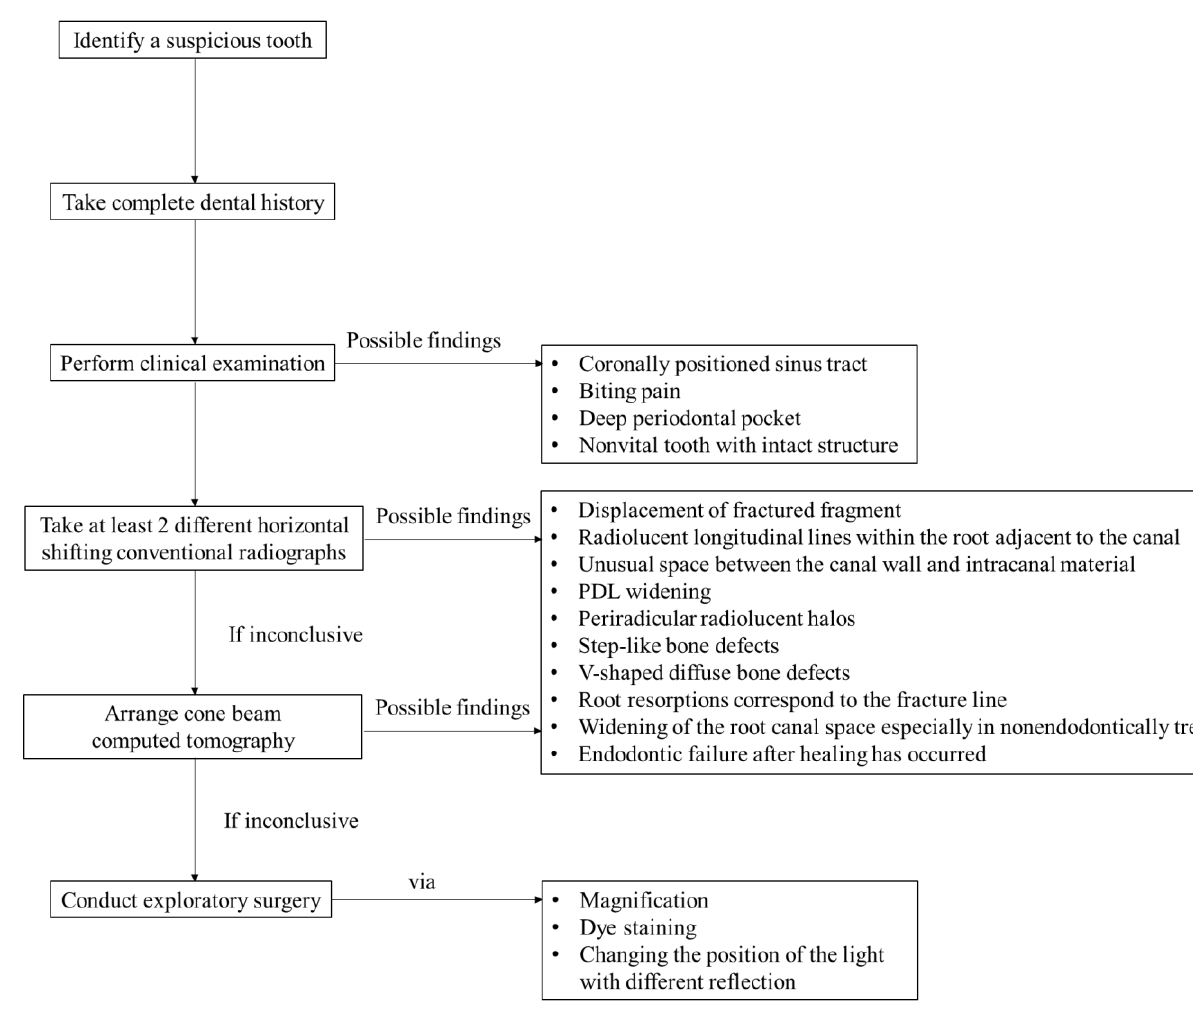
Figure 3. Diagnostic flowchart for the detection of VRF.